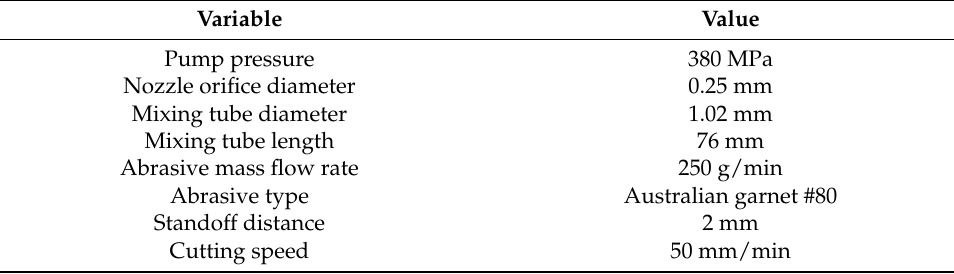
Table 2. Parameters and factors affecting the AWJM